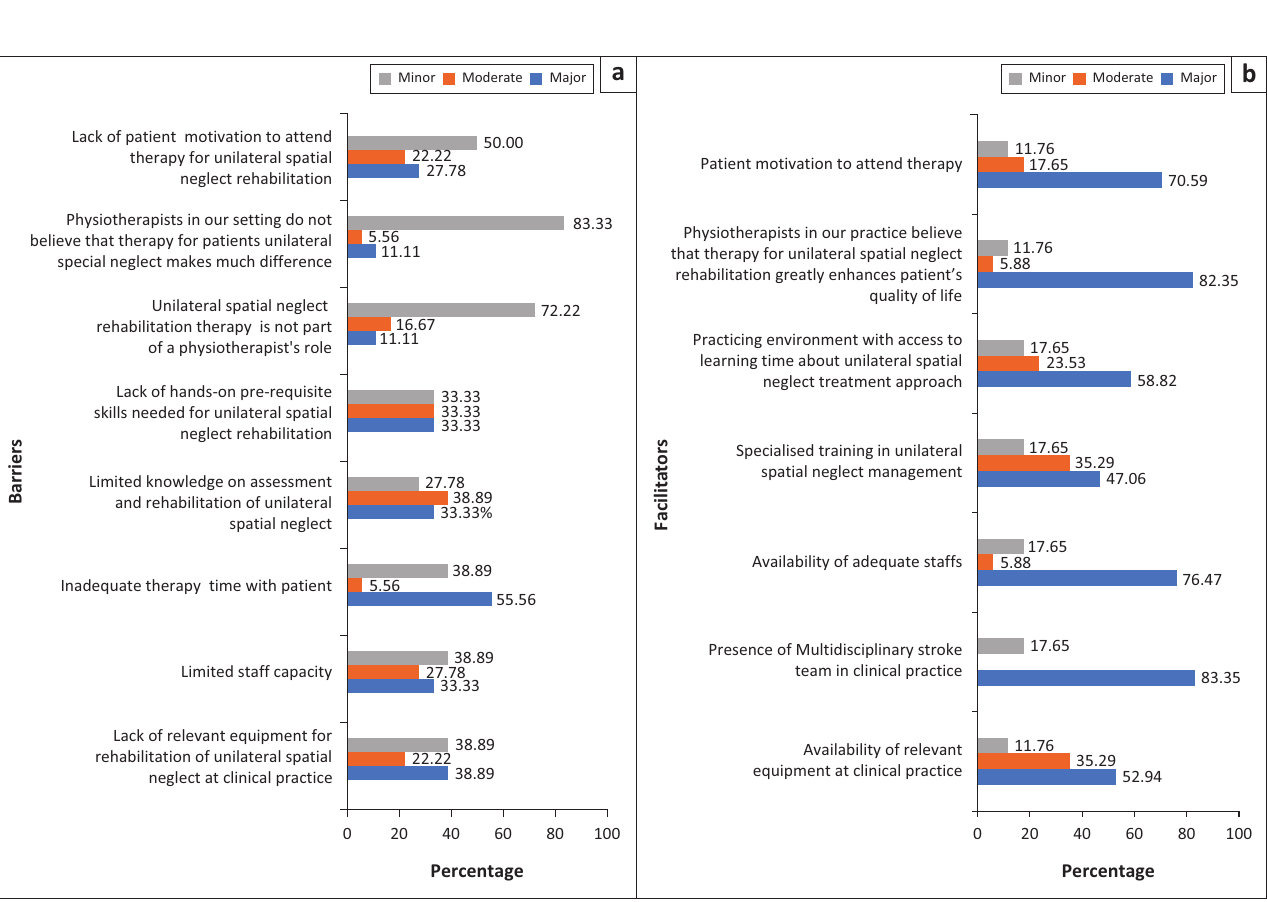
FIGURE 2: (a and b) Physiotherapist’s perceived barriers and facilitators to unilateral spatial neglect